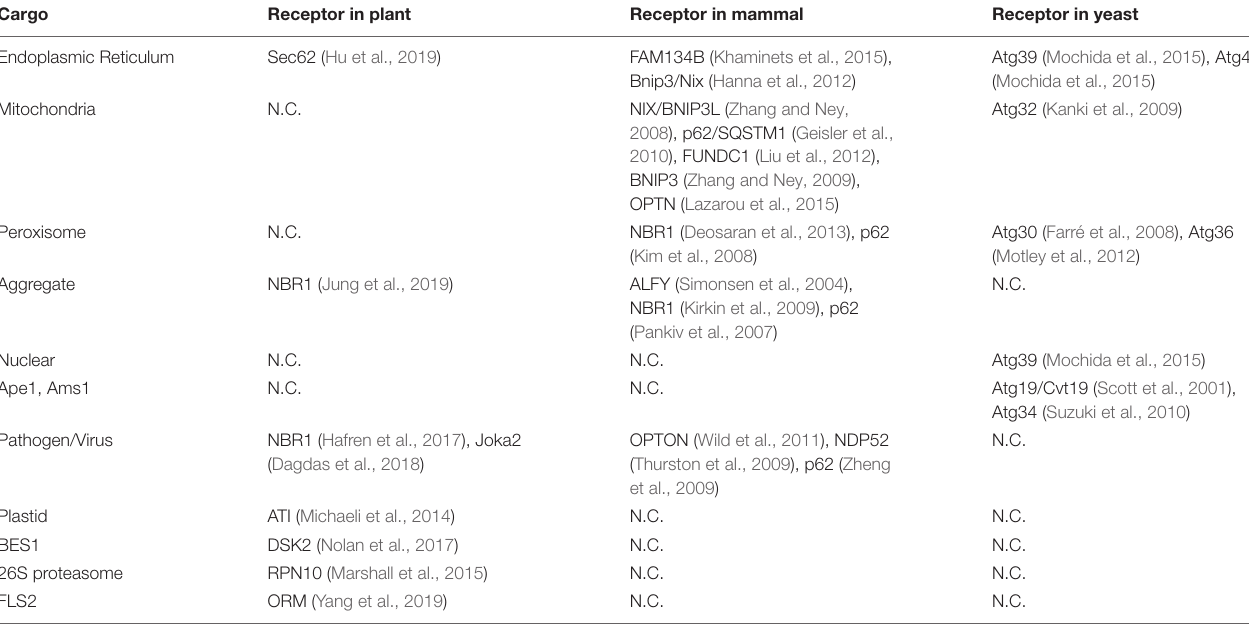
TABLE 1 | Cargo and receptor of selective autophagy in yeast, animals and